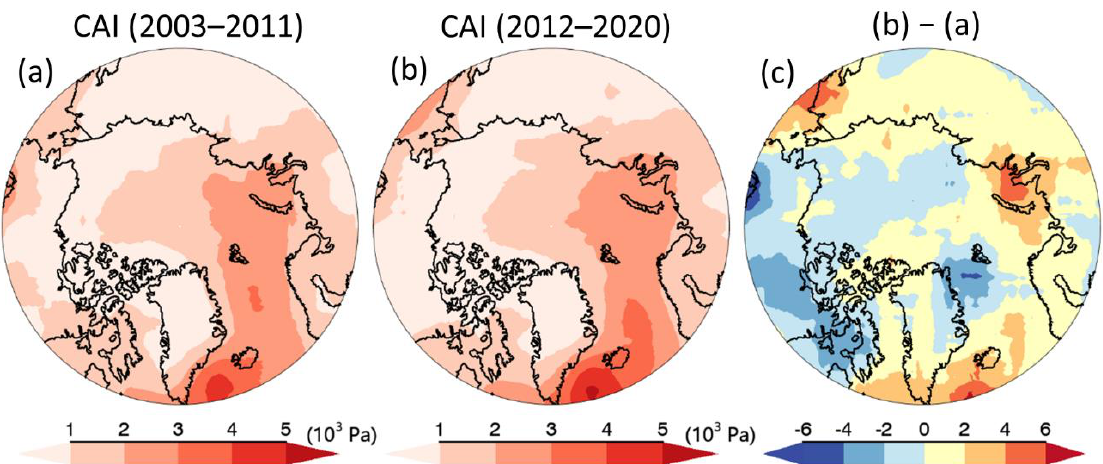
Figure 9. The winter pattern of CAI in the Arctic during ( a ) D1 and ( b ) D2. ( c ) Normalized value of the difference between ( b ) and ( c ). Note that the values over Greenland may not be accurate because defining cyclone activity at altitudes higher than 1000 m may not be realistic.